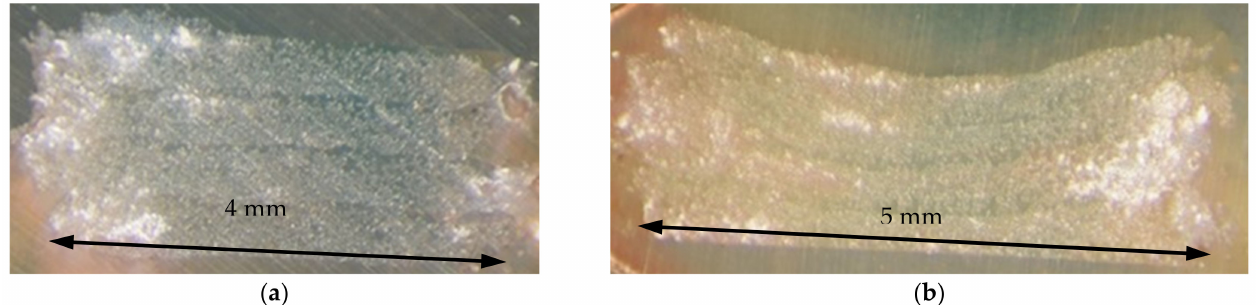
Figure 16. Cross-sections of ( a ) 0 ◦ and ( b ) 25 ◦ nozzle inclination angle